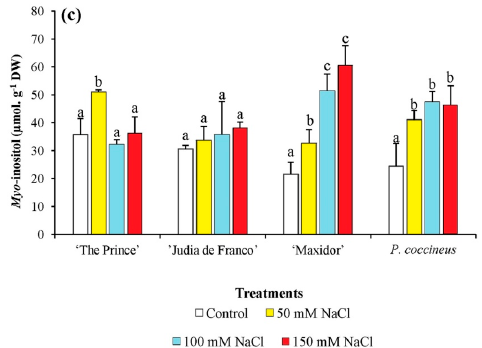
Figure 4. Salt stress-induced changes in the levels of major soluble carbohydrates of 5-week-old Phaseolus plants. Salt stress-induced changes in the levels of: ( a ) fructose; ( b ) sucrose; and ( c ) myo -inositol, separated by HPLC, in the same samples as in Figure 2. Measurements were performed after three weeks of treatment. The values shown are means with SD ( n = 5). For each cultivar, different lowercase letters indicate significant differences between treatments according to the Tukey test ( α = 0.05).